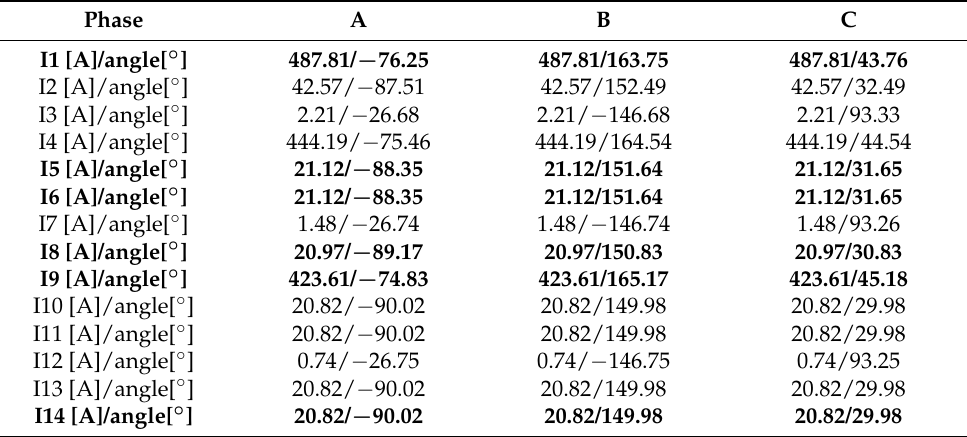
Table 4. The Fault Calculation Results for 3LG Fault at the Bus 9 in islanded mode of operation.